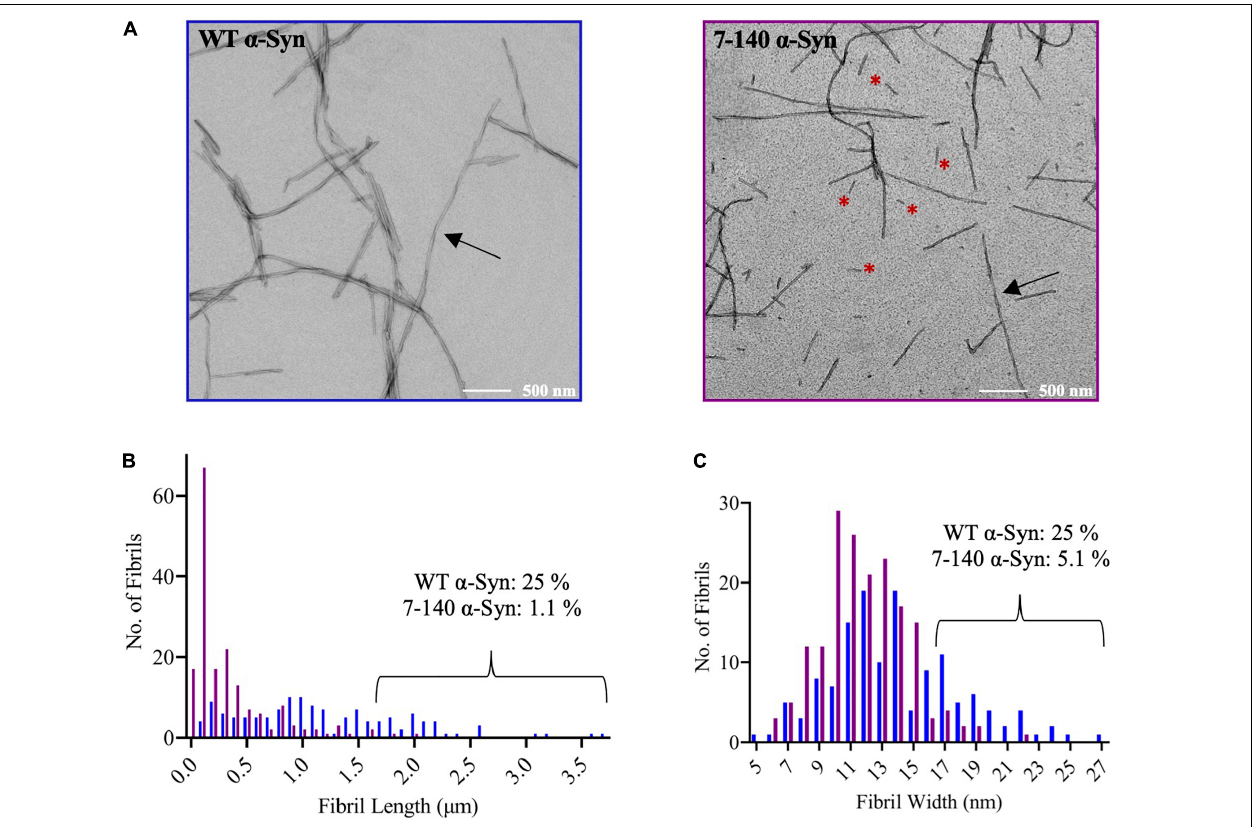
FIGURE 4 | (A) Representative TEM images of WT and 7–140 α -syn fibrils. Arrows indicate fibrils with clear twisting, red asterisks highlight short fibrils. (B) Length distribution of WT (blue, n = 132) and 7–140 (purple, n = 175) α -syn fibrils. Images used for the quantification are reported in panel (A) and Supplementary Figure 5 . The percentage of fibrils of length ≥ 1.7 µ m (75th percentile of the length distribution of WT α -syn fibrils) is shown for each variant. (C) Width distribution of WT (blue, n = 138) and 7–140 (purple, n = 175) α -syn fibrils. The percentage of fibrils of width ≥ 17 nm (75th percentile of the width distribution of WT α -syn fibrils) is shown for each